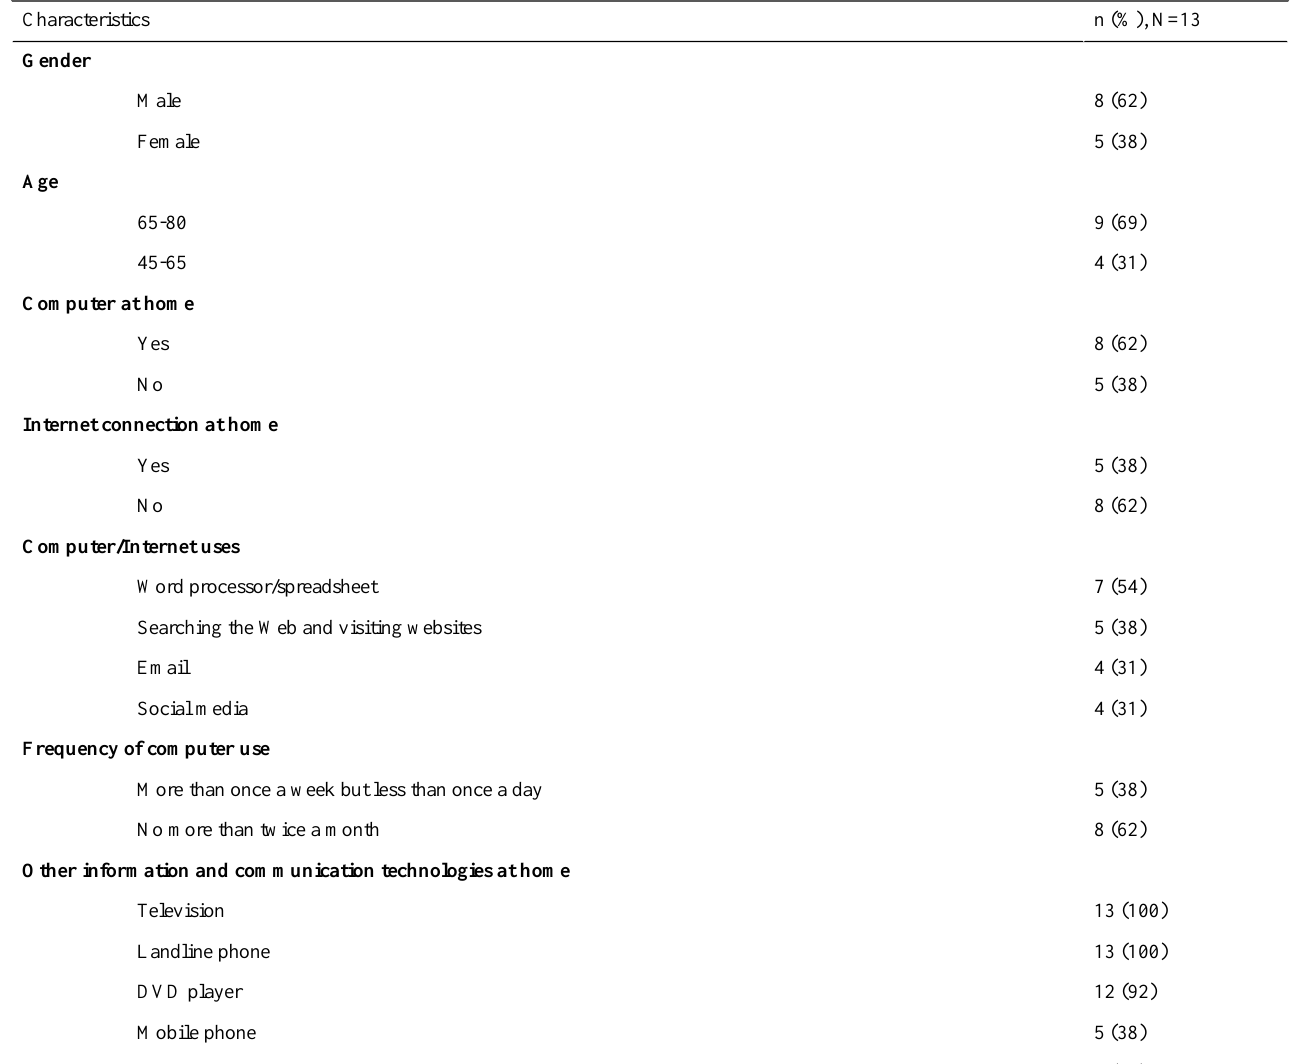
Table 1. Participating people with diabetes and their caregivers